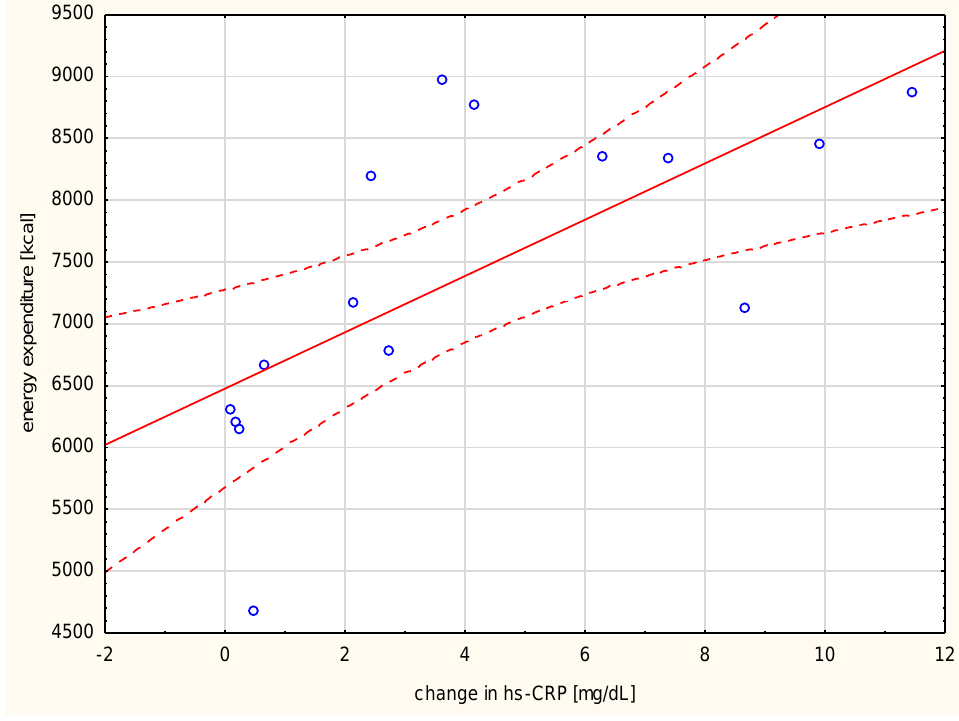
p < Figure 3. Correlation between the run energy expenditure and the change in serum hs-CRP ( r = 0.782, p < 0.001).